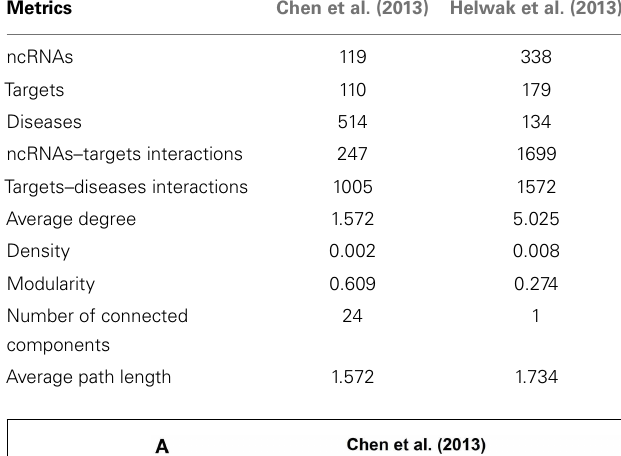
Table 1 | Description of the datasets: number of ncRNAs, targets and diseases together with the count of interactions, average degree, density, modularity, number of connected components, and average path length .